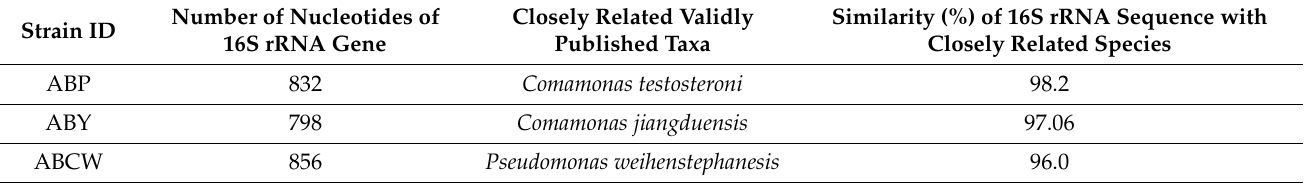
Figure 7. DNA bands of the bacterial isolates. Table 7. Molecular Identification of bacteria